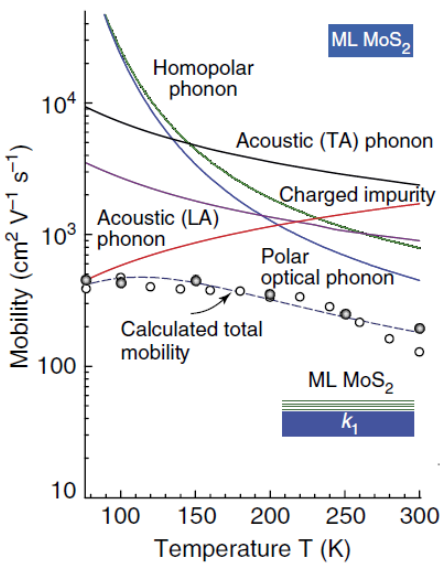
Figure 1. ( a ) A MoS 2 thin film transistor and its transport properties. ( b ) Drain current (I D ) versus back ‐ gate bias (V GS ) with different drain bias (V DS ). ( c ) Drain current (I D ) versus drain bias (V DS ) showing current saturation, including a long ‐ channel model (red lines) showing excellent agreement with measured device behavior. Reproduced with permission from [46], Nature Publishing Group, 2012.